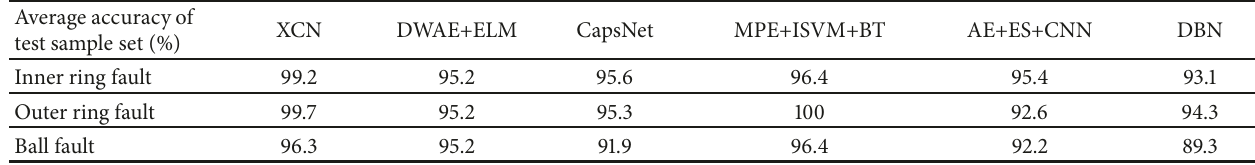
Figure 15: Average classification accuracy of different algorithms based on the test bearing data set of Western Reserve University. Table 2: Average classification accuracy of different algorithms.